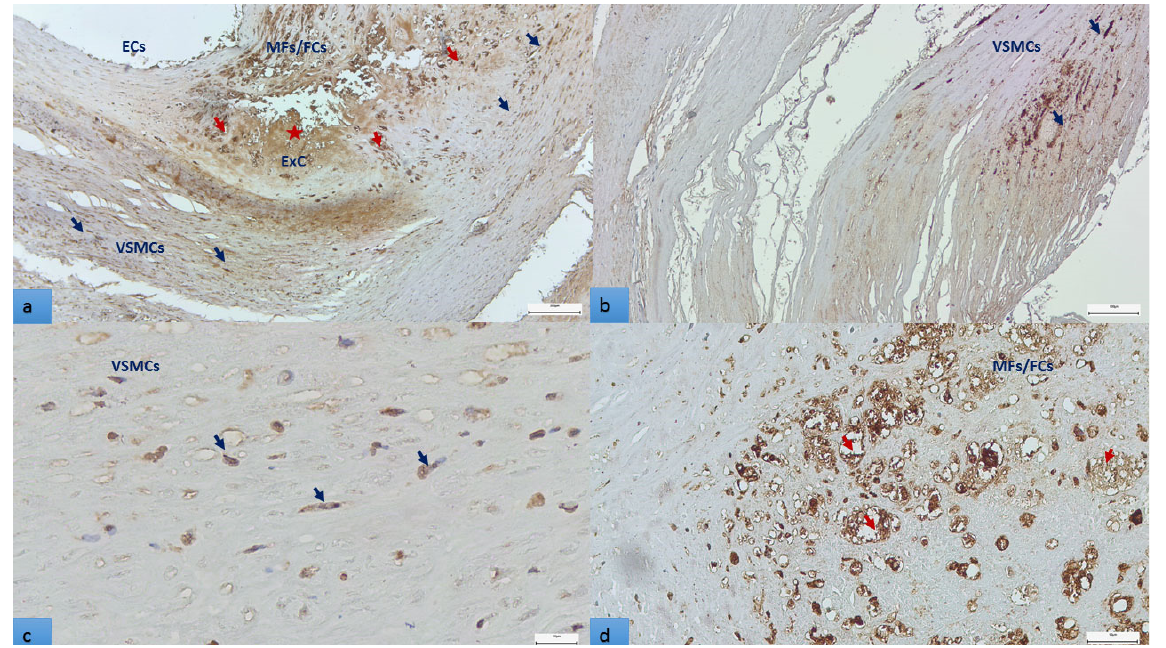
Figure 4. OPN-labelled cellular and extracellular structures in atherosclerotic plaque, immunohistochemical visualization (3,3 ′ -diaminobenzidine chromogen): ( a ). OPN positive endothelial cells, macrophages (red arrows), fibroblasts (blue arrows). OPN is also present extracellularly in the lipid core (star) ; bar represents 200 µm. ( b , c ). vascular smooth muscle cells are also OPN positive (blue arrows); bar represent 100 µm in ( b ), respectively, 20 µm in ( c , d ). OPN containing macrophages in the plaque at higher magnification. Many of these cells are foam cells with lipid droplets removed by organic solvents used for tissue processing, empty for OPN (red arrows); bar represents 50 µm.